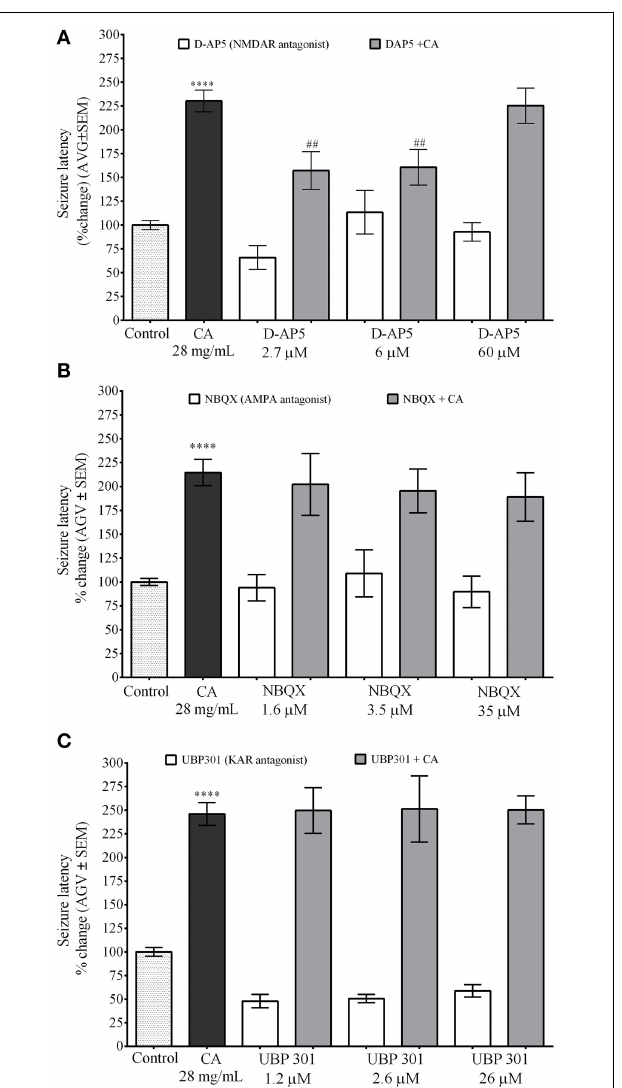
FIGURE 4 | Selective interaction of C. aurantium extract with glutamate receptors In vitro . Synaptic membranes were incubated with C. aurantium extract at 1.4mg/mL in the presence of 1mM of agonists for iGluR’s o mGluR’s and 20nM [ 3 H]glutamate. For these experiments, nonspecific binding was 22% of total binding (represented with a dotted line). All treatments significantly reduced [ 3 H]Glu binding, when compared with Total binding. (A) C. aurantium 1.4mg/mL reduced ligand binding in the presence of ionotropic glutamate receptor agonist for NMDA, AMPA, and KA receptors compared to the agonist alone. (B) C. aurantium 1.4mg/mL reduced ligand binding in the presence of metabotropic glutamate receptor agonist for mGluR II (LCCG-I, DCG-IV) and mGluR III (L-AP4) when compared to the agonist alone. Results are shown as percentage of total binding ± SEM of three experiments. ++ vs. Agonist P < 0 . 01; ++++ P < 0 . 0001. ## vs. CA1.4mg/ml P < 0 . 01; ### P < 0 . 001.